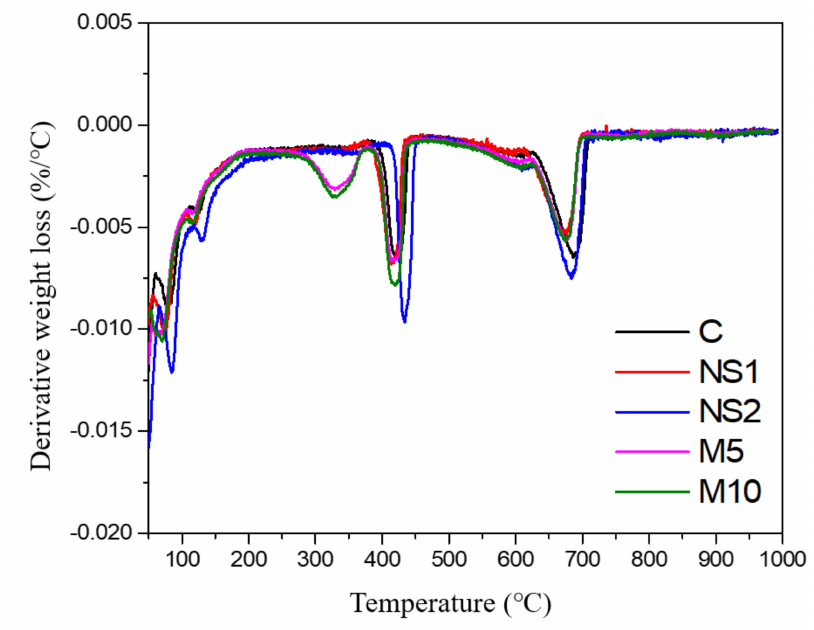
Figure 8. DTG curves of the UWC mixes with different amounts of NS and MgO.